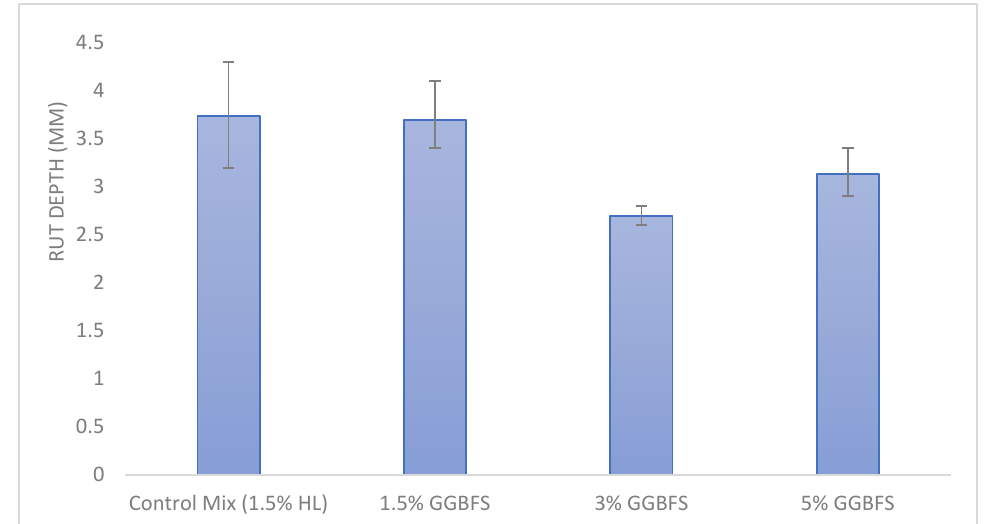
Figure 7. Rutting depths of different asphalt mixtures.